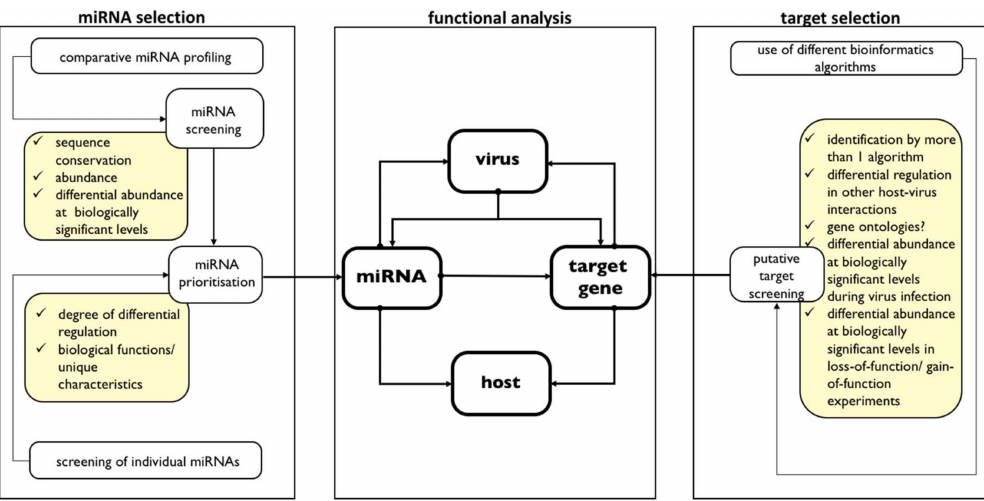
Figure 1. Suggested pipeline and criteria for analysis of the miRNA function in host-virus interaction. Identification of miRNAs with important roles in host-virus interactions typically starts with miRNA profiling. Comparison of uninfected and infected samples commonly identify many miRNAs with differential abundance upon infection. Especially for pilot studies, miRNA screening and miRNA prioritisation using the outlined criteria (in yellow-shaded boxes, left panel) will help streamline and focus research. Identification of targets by bioinformatics also generate many putative mRNA targets. Screening using the outlined criteria (in yellow-shaded boxes, right panel) will as well aid in narrowing down the putative targets. Once miRNA of interest has been identified, and its target confirmed, a closed-loop inter-relationship amongst the (1) miRNA, (2) target gene, (3) virus, and (4) host has to be confirmed (centre panel) to categorically identify the miRNA-target pair as being relevant in the host-virus interaction. Where LOF/GOF mutants exist, identification of relevant miRNAs can start with genetic screens (left